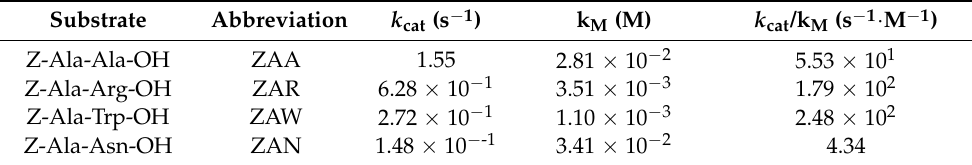
Table 1. Functional characterization of ChtCP versus substrates with benziloxicarbonil (Z).